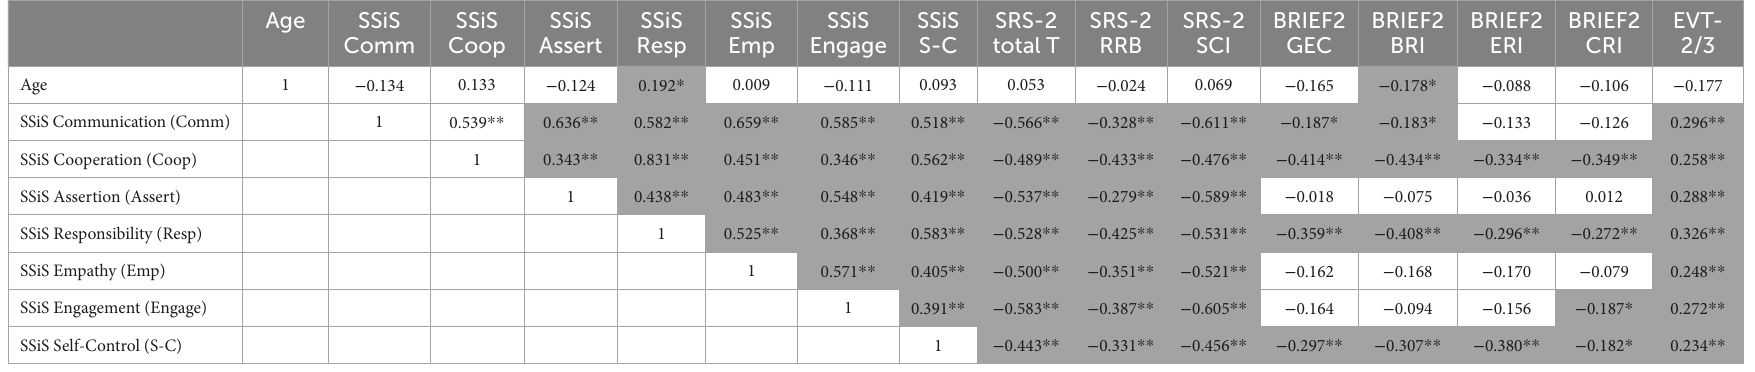
TABLE 4 Pearson’s r correlation coefficients for SSiS Social Skills subscale raw scores and other study